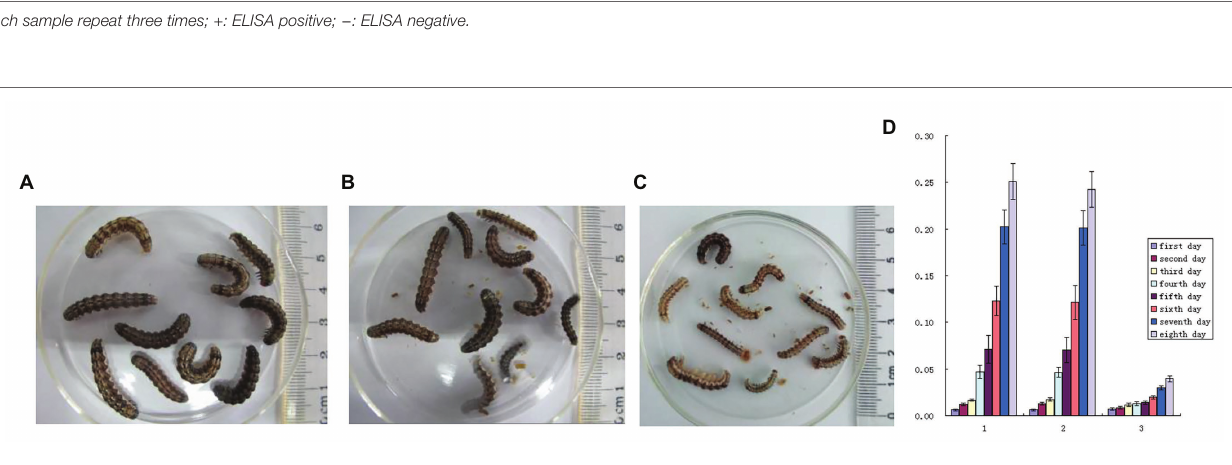
FIGURE 5 | Larvae feeding bioassay. (A) : larvae feed with larva fodder mix with GM sugar; (B) : larvae feed with larva fodder mix with non-GM sugar; (C) : larvae feed with larva fodder mix with GM sugarcane stem material. (D) : 1: Daily average weight of 10 larvae fed with larva fodder mix with GM sugar; 2: Daily average weight of 10 larvae fed with larva fodder mix with non-GM sugar; 3: Daily average weight of 10 larvae fed with larva fodder mix with GM sugarcane stem material.